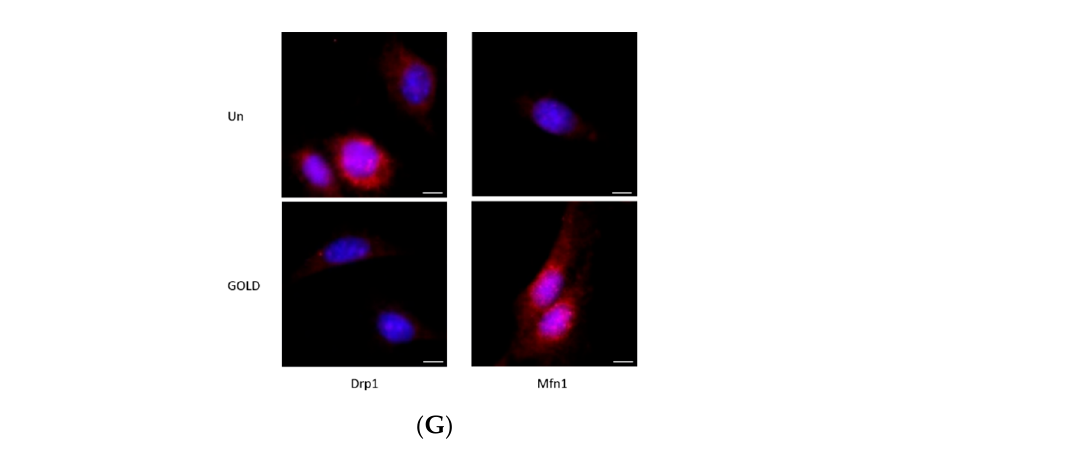
Figure 5. Regulation of mitochondrial function by GOLD. The expression and function of mitochon- dria under GOLD treatment (500 µ M) were investigated. ( A ) SV40 MES 13 cells were incubated with MitoTracker Orange. Mitochondrial morphology and expression were investigated using confocal microscopy. ( B ) Mitochondrial membrane potential was measured using an ELISA kit. Mitochondrial genes were assessed in SV40 MES 13 cells. FCCP expression was measured as a positive control. ( C ) The mitochondrial membrane potential was determined using confocal microscopy and an ELISA kit. Quantitative analysis of tetraethylbenzimidazolylcarbocyanine iodide (JC-1)-stained cells using flow cytometry. SV40 MES 13 cells were pretreated with 500 µ M GOLD for 24 h and then stained with JC-1 for 20 min. ( D ) Adenosine triphosphate (ATP) content in the untreated and GOLD-treated groups. Data are expressed as the mean ± standard deviation (represented by vertical bars; n = 3). ( E ) Basal glucose transport and insulin-stimulated glucose transport rates are shown. The basal rate refers to the rate of glucose transport in the absence of insulin. All values were normalized to the basal rate. ( F ) The expression of mitochondrial fusion and fission-related genes was investigated to determine mitochondrial dynamics using Western blotting. β -actin expression was measured as an internal control. ( G ) Cells were incubated with anti-DRP1 and –MFN1 primary antibodies, followed by Alexa 488-labeled anti-mouse IgG. Cells were observed under fluorescence microscopy at × 400 magnification. Data are expressed as the mean ± SEM of three independent experiments. * p < 0.05 indicates a significant difference compared to the untreated